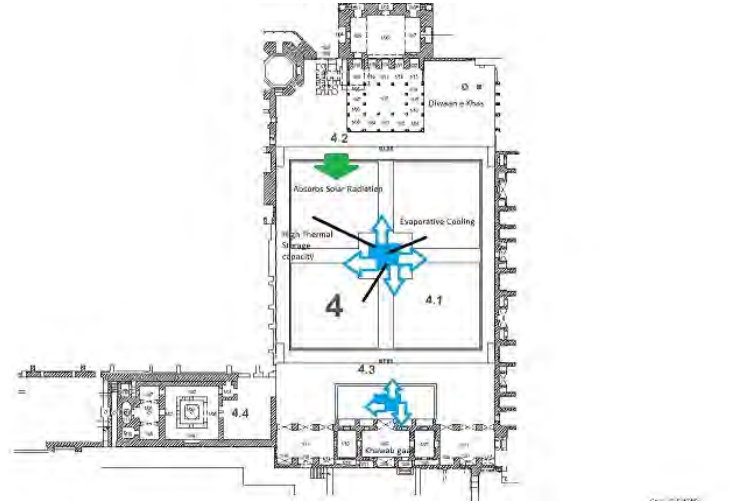
Figure 8. An illustration of Shah Jahan’s quadrangle